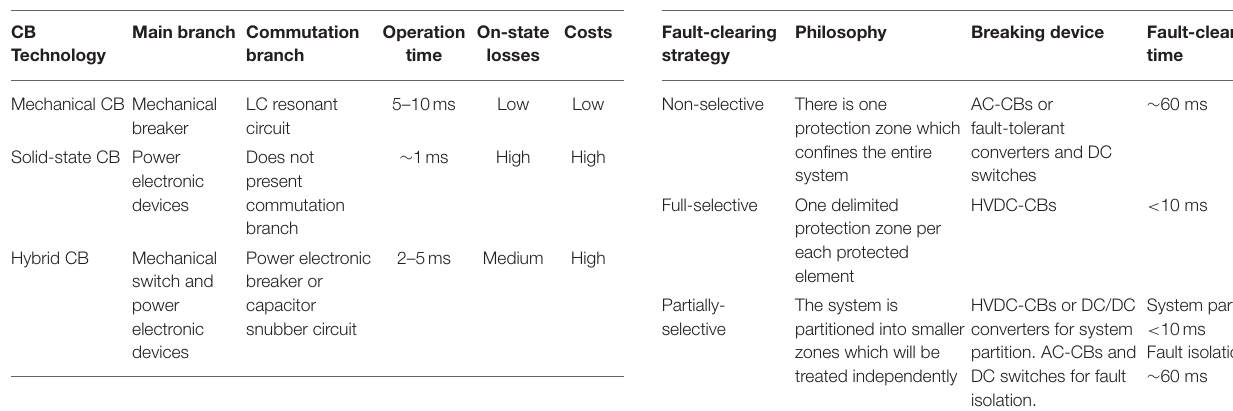
TABLE 1 | Comparison of HVDC circuit breaker technologies. TABLE 2 | Comparison of fault-clearing